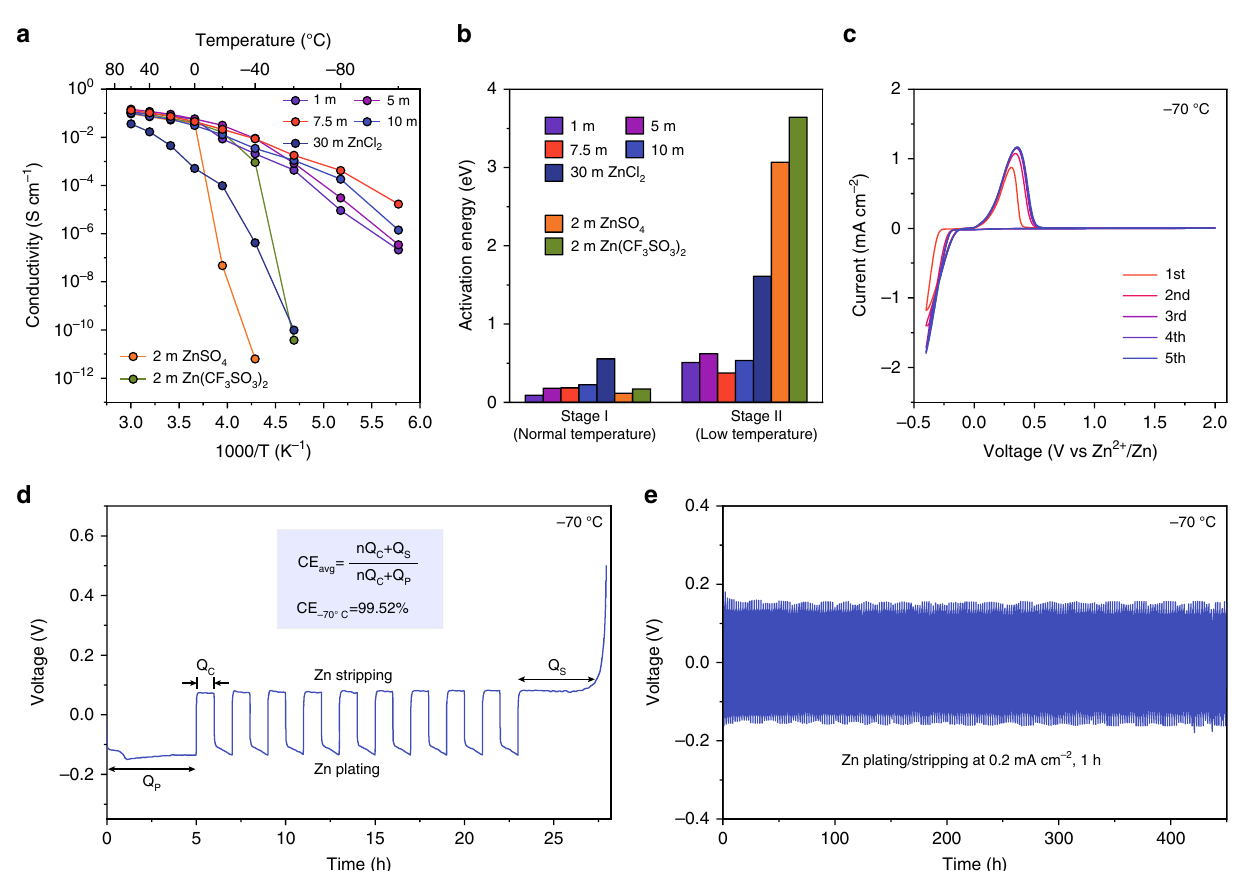
Fig. 4 The electrochemcial performance of the LTE and Zn anode. a The ionic conductivities of the different electrolyte in the temperature range of – 100~ + 60 °C. b The activation energies of ionic conduction in the different electrolyte at normal temperature and low-temperature stages. c CV curves of asymmetric Zn||Cu cell at – 70 °C. d The voltage pro fi les of Zn plating/stripping in asymmetric Zn||Cu cell at – 70 °C. e The cycling performance of symmetric Zn||Zn cell at – 70